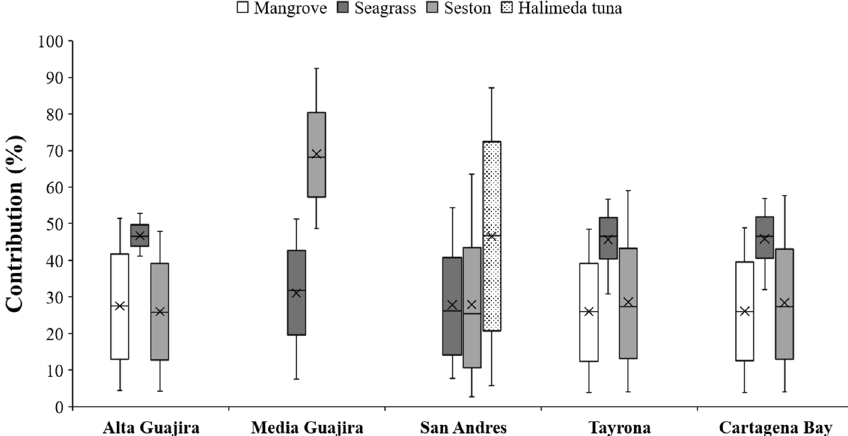
Figure 2. Box plots showing the results of the isotope mixing models to determine the contribution of sources (seagrass, seston, Halimeda tuna and mangrove) to the soil organic carbon pool in the five study